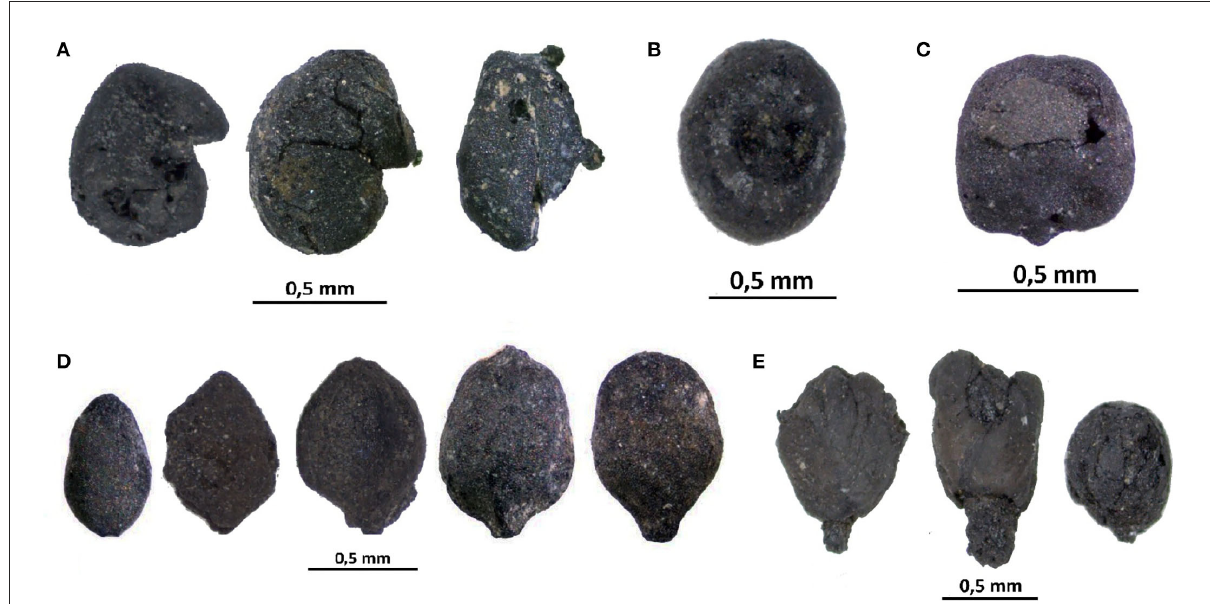
FIGURE8 Most dominant wild plant taxa from Chap II site: Medicago/Melilotus spp. (A) , Galium sp. (B) , Eragrostis sp. (C) , Carex spp. (D) , and Eragrostis sp. inflorescence (E)